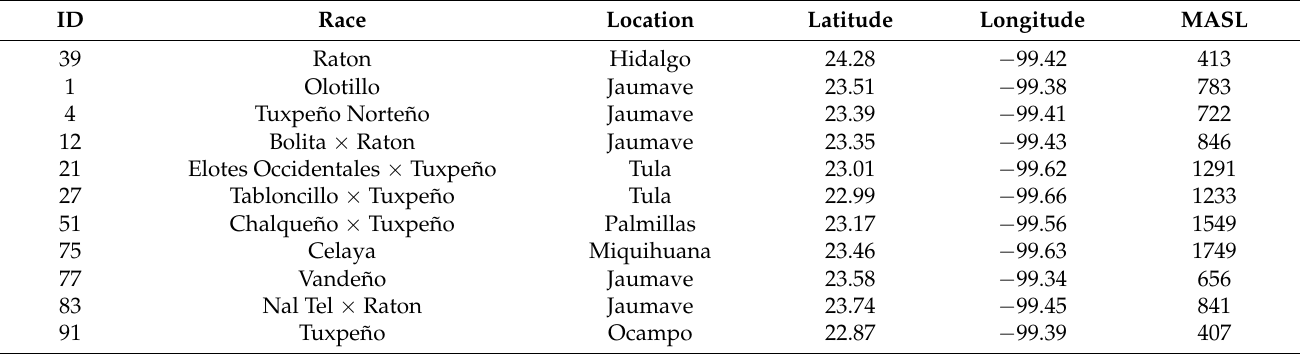
Table 10. Race of maize used for the study of resistance to Tetranychus merganser